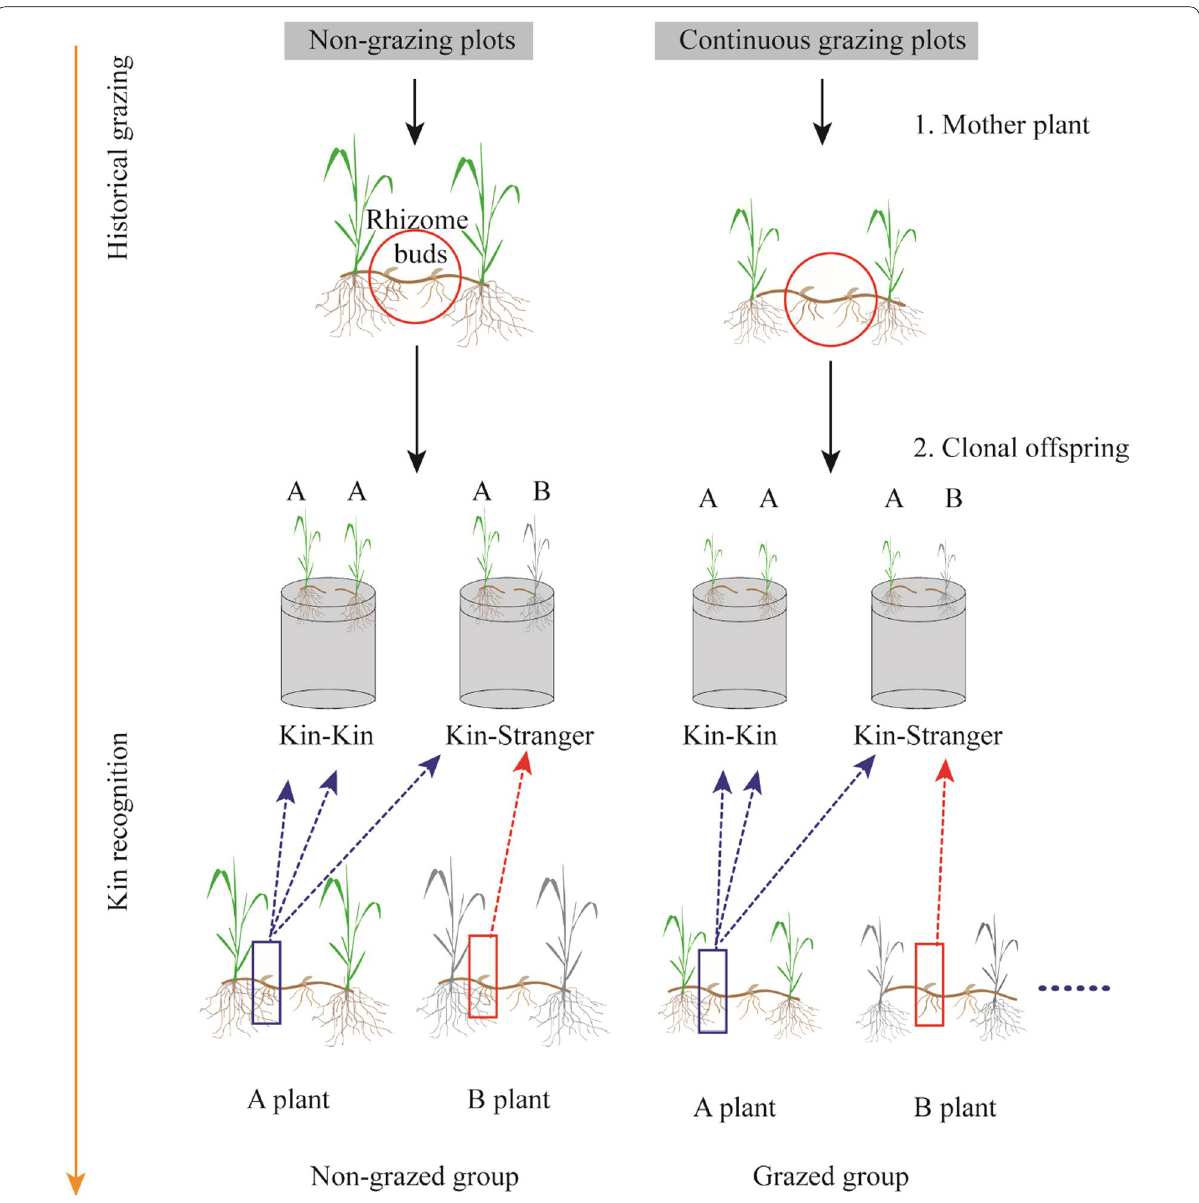
Fig. 1 Schematic diagram of the experimental design. The clonal offspring of Leymus chinensis that had experienced either a 9-year period of continuous grazing or non-grazing were used. The same letters indicate kin group L. chinensis offspring from the same plant. Kin plants were the clonal siblings from the same mother as the focal L. chinensis plant, whereas stranger plants were from different